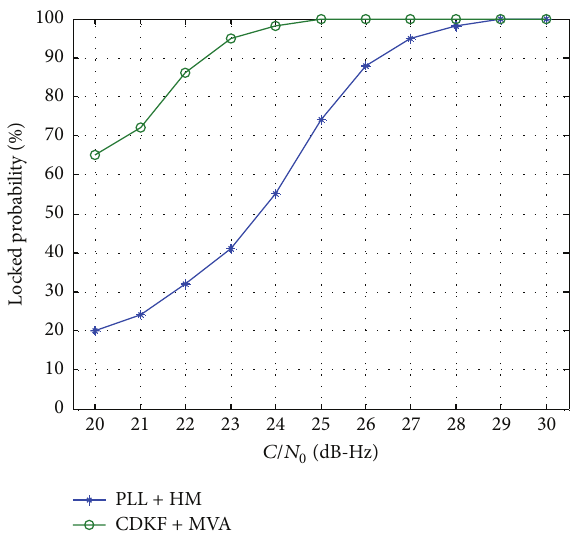
Figure 7: The loop stability to different